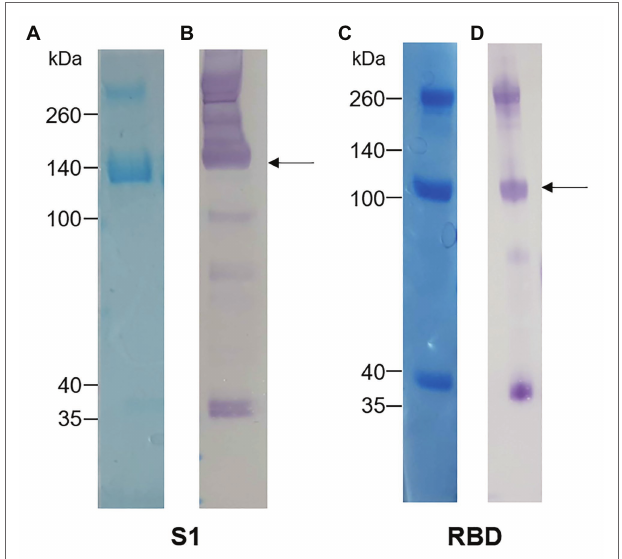
FIGURE 1 | Analysis of plant-expressed severe acute respiratory syndrome coronavirus 2 (SARS-CoV-2) spike antigens after Protein A purification. (A) Coomassie-stained SDS-PAGE gel and (B) Western blot of S1-rabbit Fc fusion protein (2 μ g of concentrated elution fraction). Lines on the left indicate molecular weight marker (Spectra Multicolor Broad range protein ladder) in kDa. The arrow indicates the expected size for recombinant S1 protein (~140 kDa). (C) Coomassie-stained SDS-PAGE gel and (D) Western blot of RBD-rabbit Fc fusion protein (5 μ g of concentrated elution fraction). Arrows indicate expected size for RBD-rabbit Fc conjugate (~100